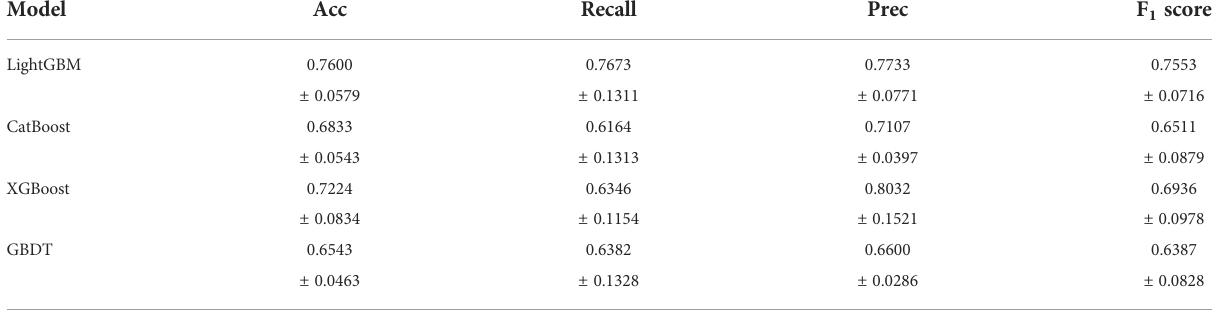
TABLE 4 5-fold cross-validation results for recurrence prediction using different ensemble learning